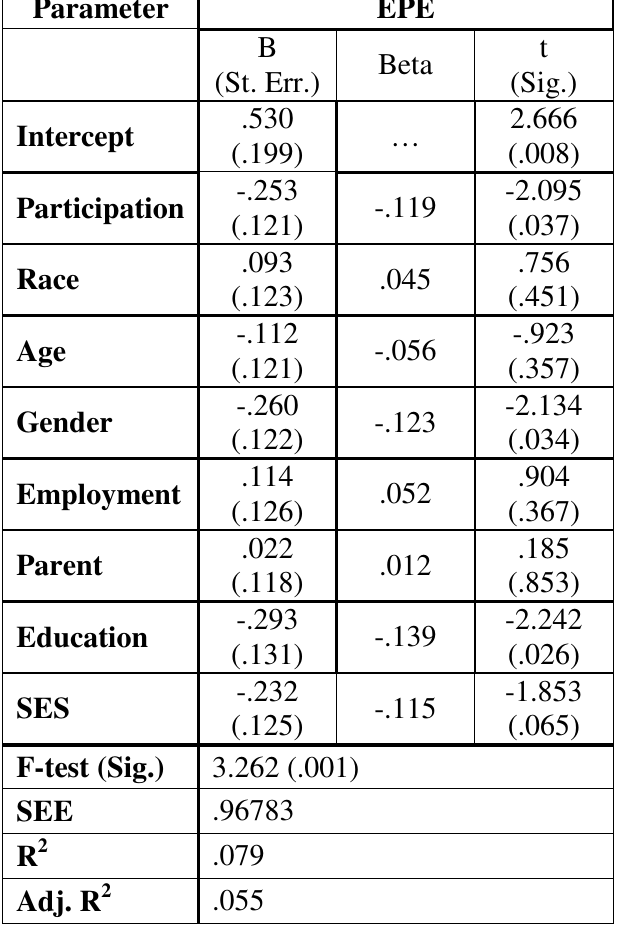
Table 4: OLS Results - EPE among Participants and Non-Participants at Time